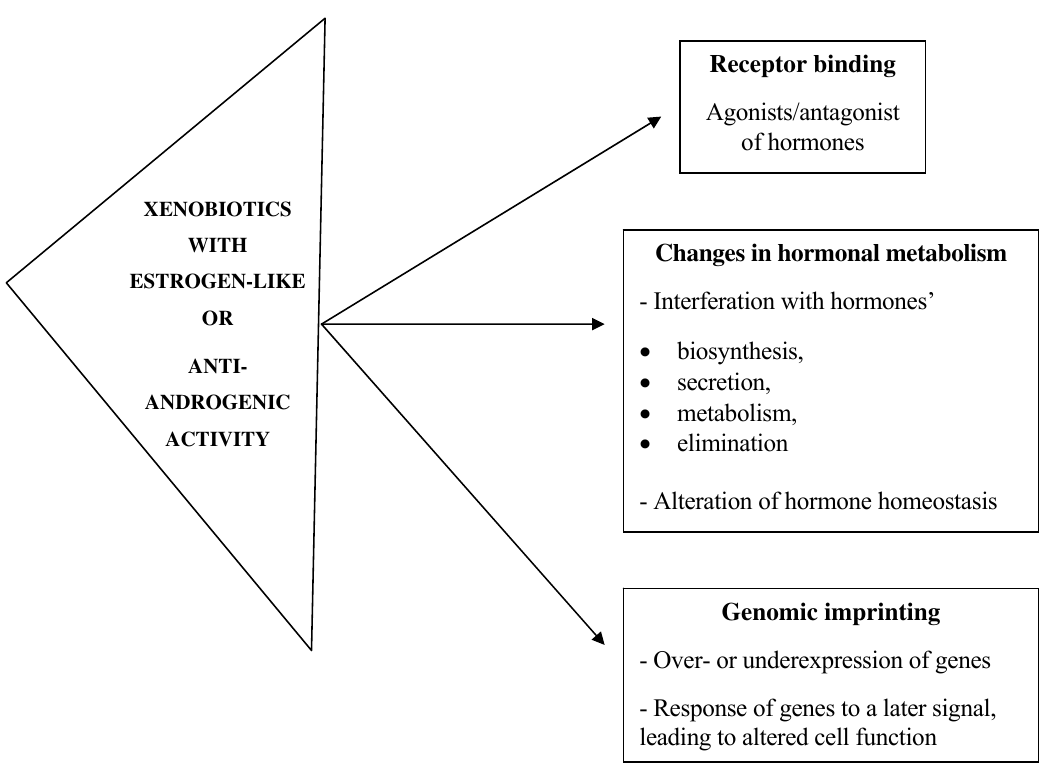
Fig. 2 Known mechanisms of xenobiotics’